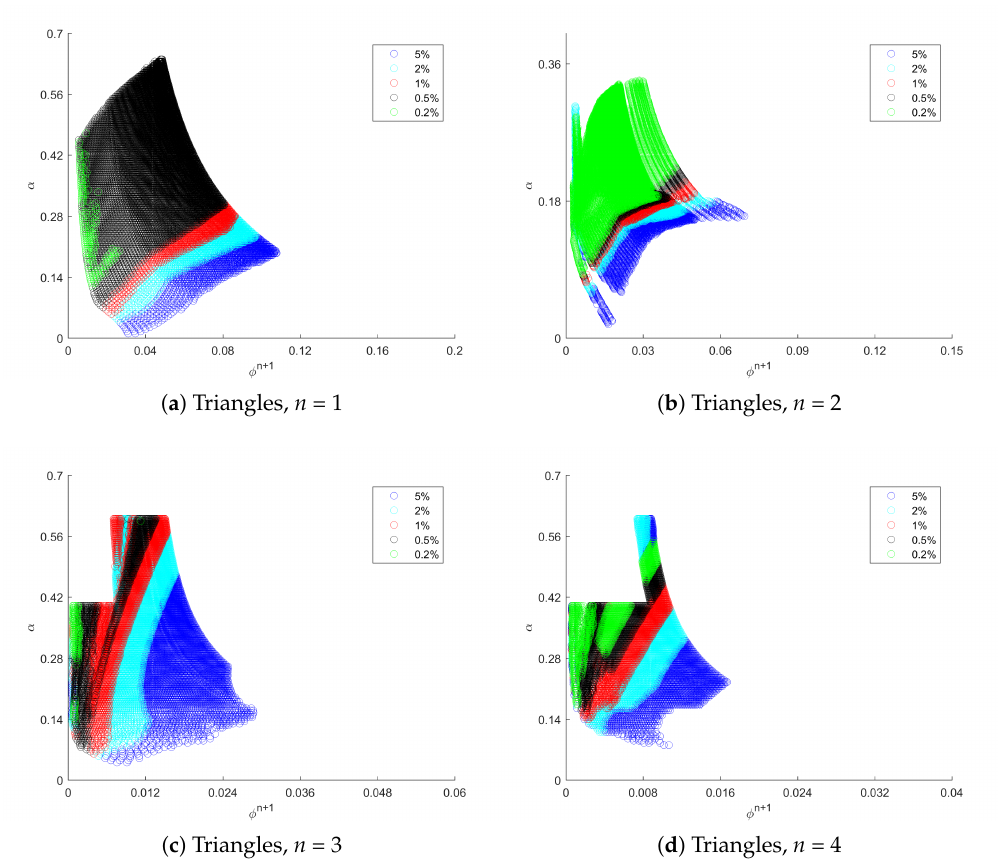
Figure 1. L ∞ percent errors in density from a series of shock tube problems with various initial pressure ratios. The errors are plotted as a function of α and φ n + 1 for each polynomial order of triangular